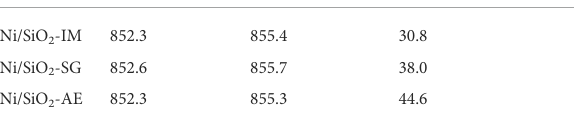
TABLE 2 XPS deconvolution results of Ni.